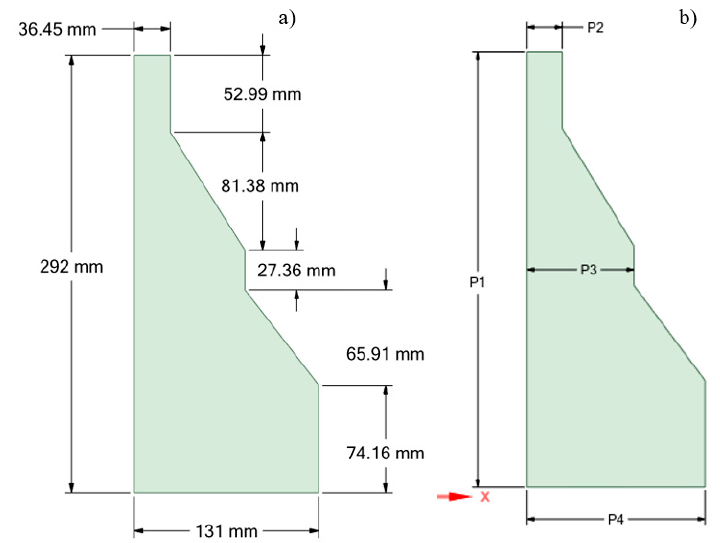
Figure 3. ( a ) The dimensions of the desired geometry and ( b ) the input optimized parameters.